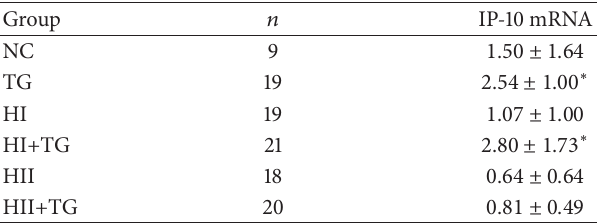
Table 5: Expression of IP-10 mRNA in the rat thyroid (mean ±